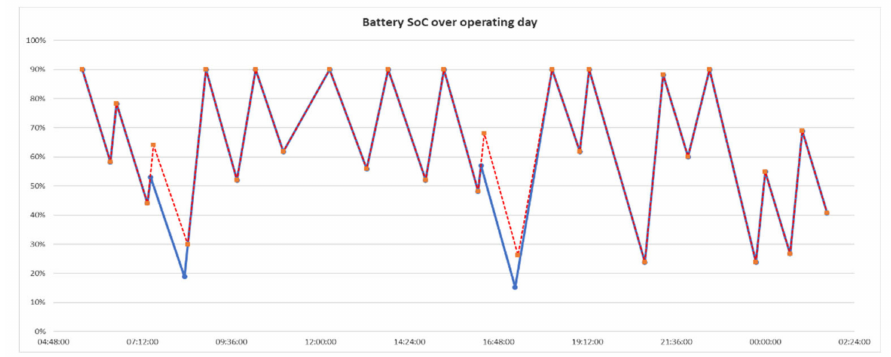
Figure 2. Simulated battery SoC for the Stavanger demonstrator and the e ff ect of extending the charging time by 5 min (dotted line)